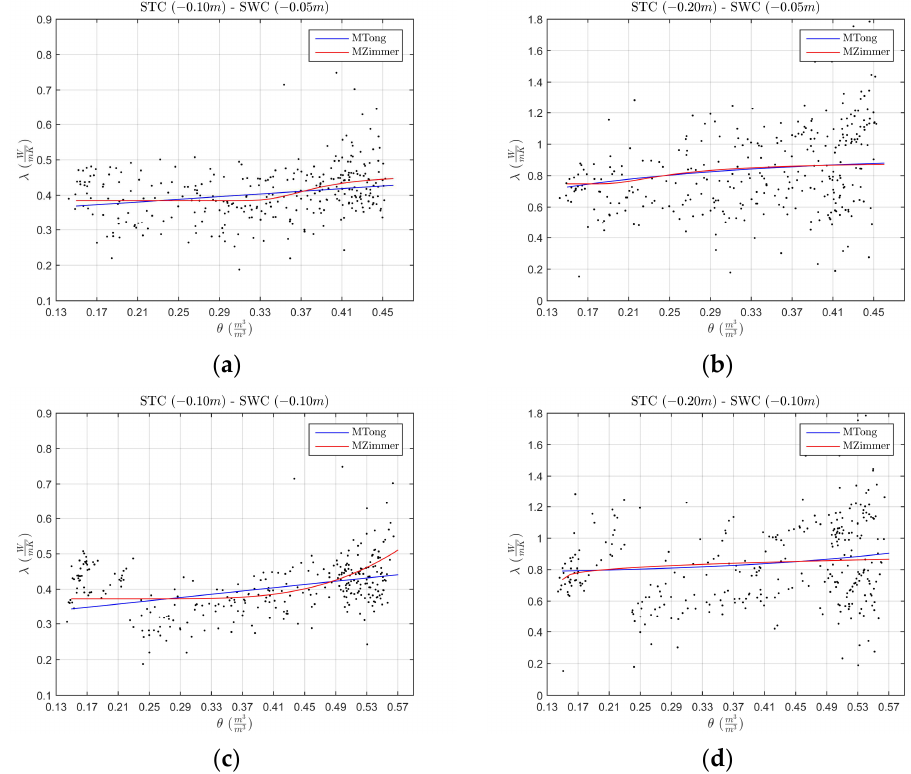
Figure 5. Soil thermal conductivity ( λ ) as a function of daily soil water content ( θ ) and the calibrated models MTong and MZimmer; ( a ) level 1 and θ 1 ; ( b ) level 2 and θ 1 ; ( c ) level 1 and θ 2 ; ( d ) level 2 and θ 2 . Table 4. Estimated parameters from the MTong and MZimmer models and statistical indices for